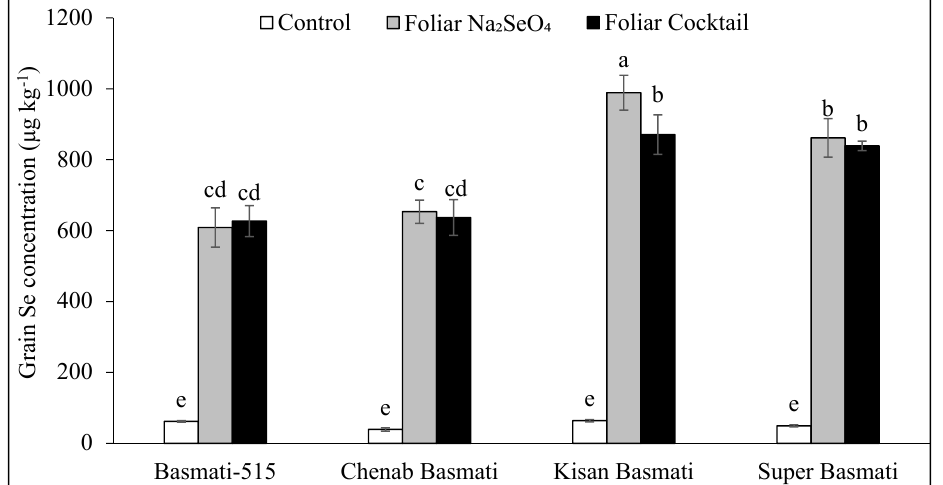
Figure 2. Effect of foliar application of Na 2 SeO 4 (0.0024%) alone or contained in a cocktail together with KIO 3 (0.05%) and ZnSO 4 ∙ 7H 2 O (0.5%) on Se concentration in brown rice grains of different Basmati rice cultivars. Control, two foliar sprays of distilled water; Foliar Na 2 SeO 4 ; two foliar sprays of 0.0024% Na 2 SeO 4 ; Foliar Cocktail, two foliar sprays of a mixture of 0.05% KIO 3 , 0.0024% Na 2 SeO 4 , and 0.5% ZnSO 4 ∙ 7H 2 O. Data bars (mean ± SE) having different letters differed significantly at p = 0.05. LSD: Cultivar = 57.6, Treatment = 49.9, Cultivar × Treatment = 99.8.